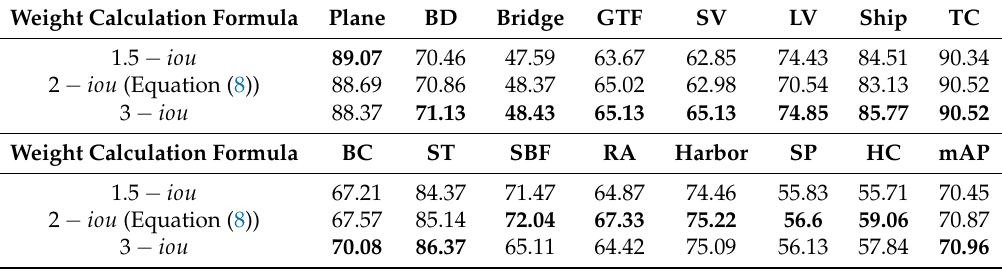
Table 7. The impact of using different weight calculation formulas. We have designed three different regression loss weight calculation formula, and we evaluate on val set, The best results on each category is highlight in bold.